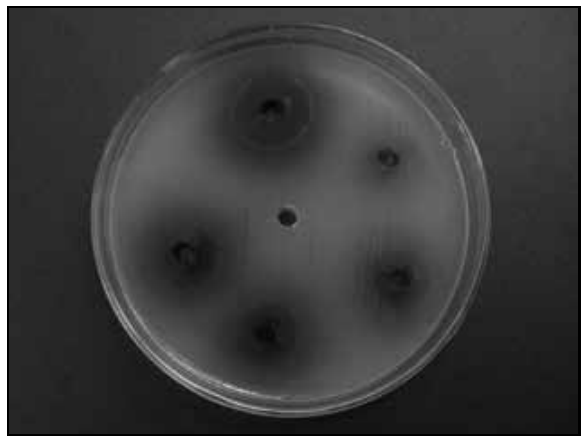
Figura 2 – Teste de sensibilidade da cultura de E. faecalis (ATCC 29212) ao extrato de aroeira-do-sertão ( Astronium urundeuva [Fr. All.] Engl. ) no ágar Muller-Hinton (Difco), decorridas 48 horas de incubação a 37 o C